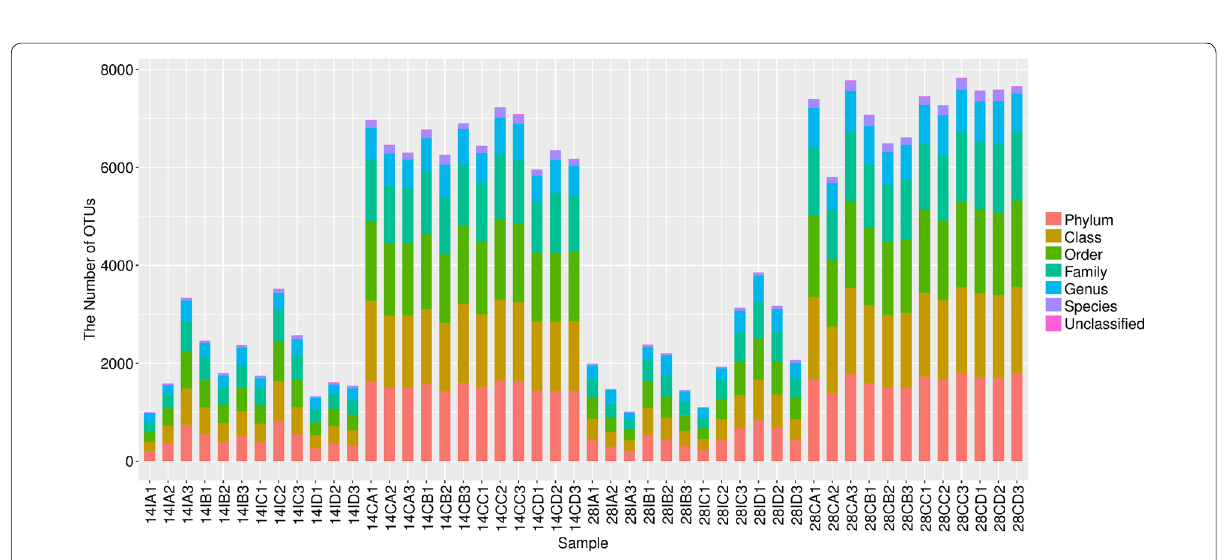
Fig. 3 Number of identified taxa (from phyla to species) among the diverse